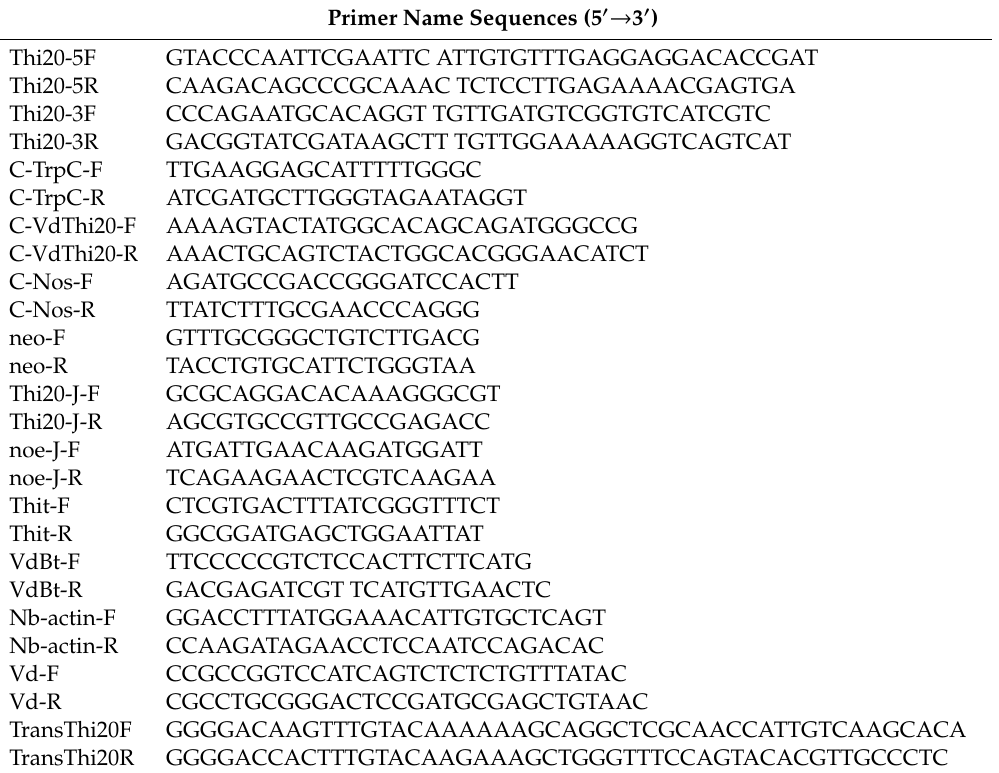
Table 2. Primers used in this